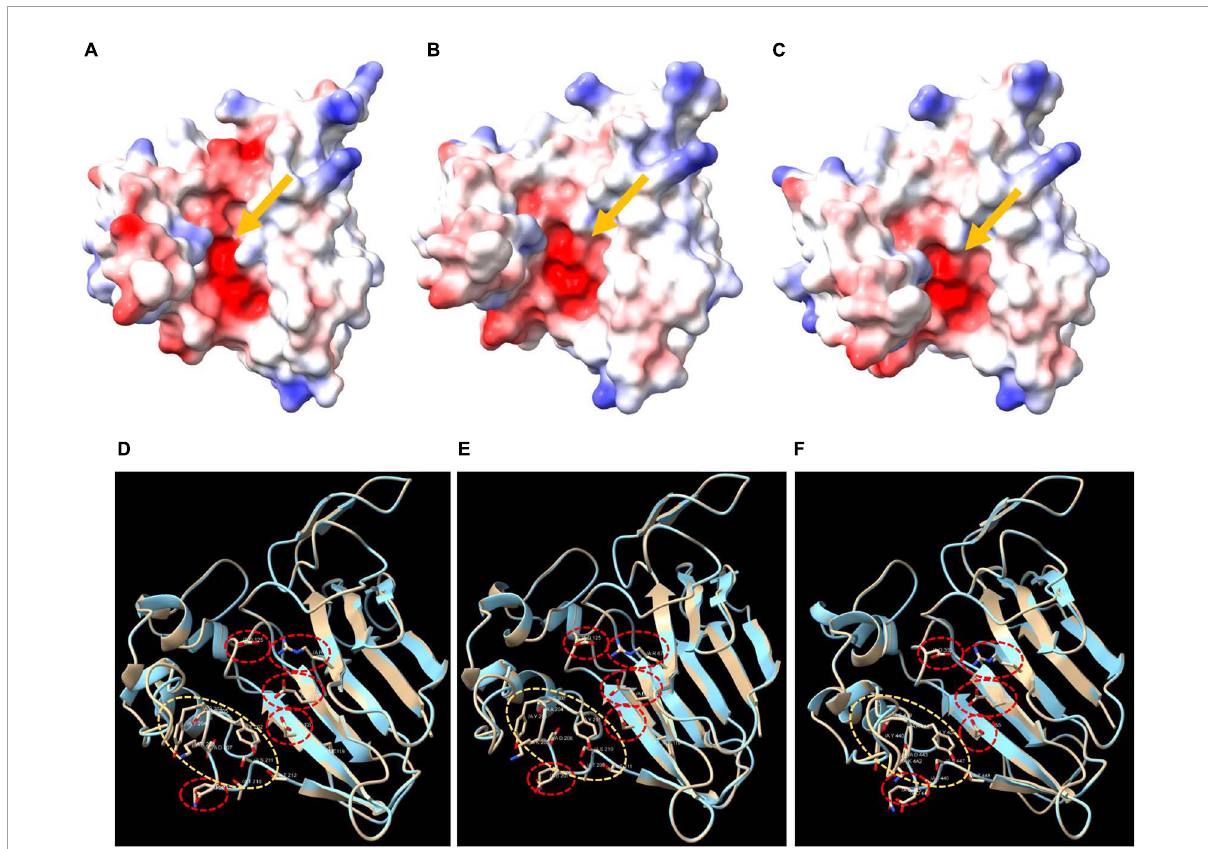
FIGURE4 The electrostatic surface and the 3D structure of three Qingke TLPs. (A–C) The electrostatic surface of HOVUSG6558000, HOVUSG5063500 and HOVUSG5062800, respectively. Surfaces where the electrostatic potential is positive are colored blue, while those negatively charged are colored red. The arrows point to the acidic clefts formed by five conserved residues (REDDD). (D–F) The 3D structure of HOVUSG6558000, HOVUSG5063500 and HOVUSG5062800, with residues of the REDDD motif (red circles) and the bottom of acidic cleft forming regions (yellow circles)